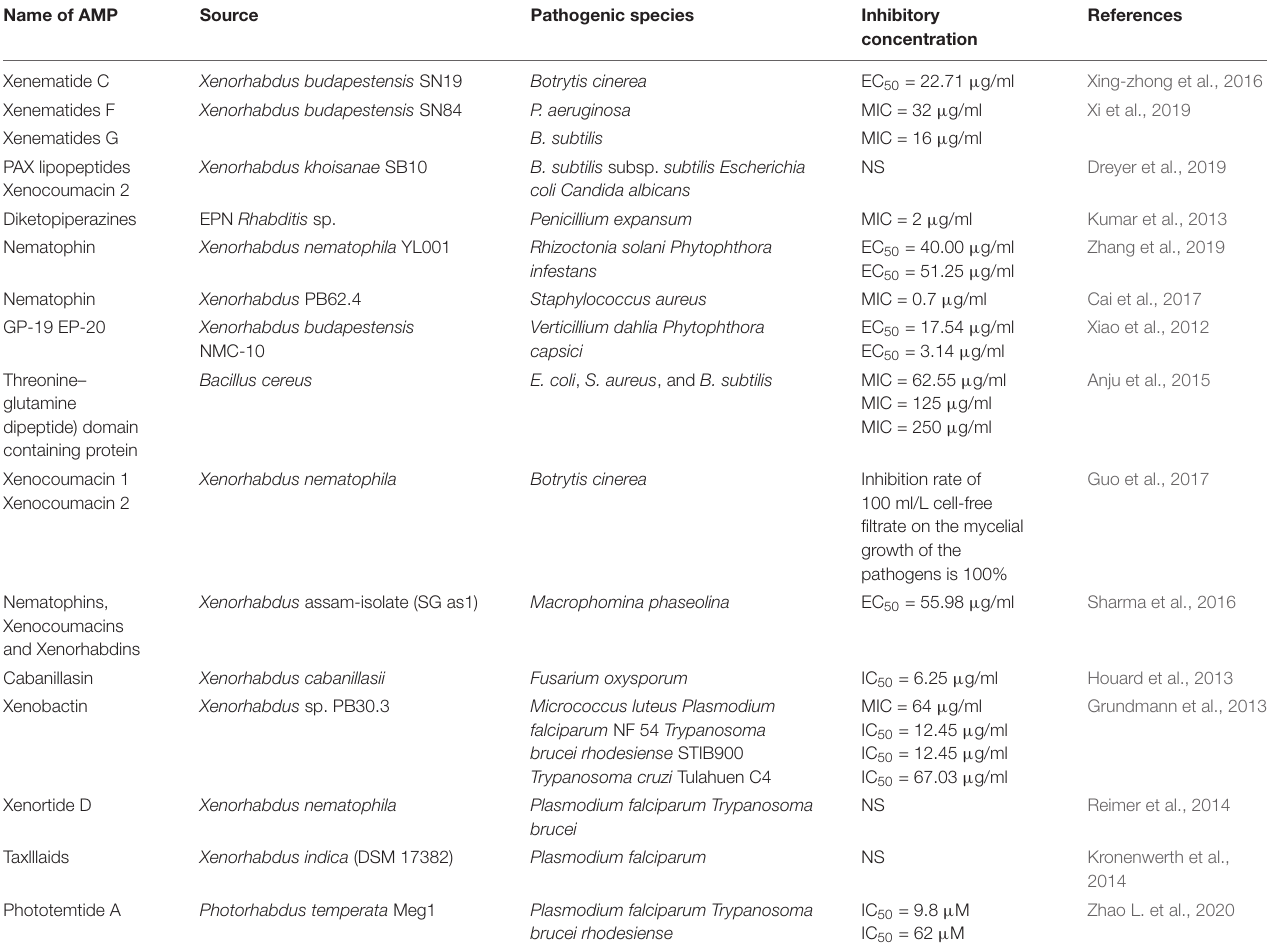
TABLE 2 | Antimicrobial peptides from nematobacterial complexes with their inhibitory